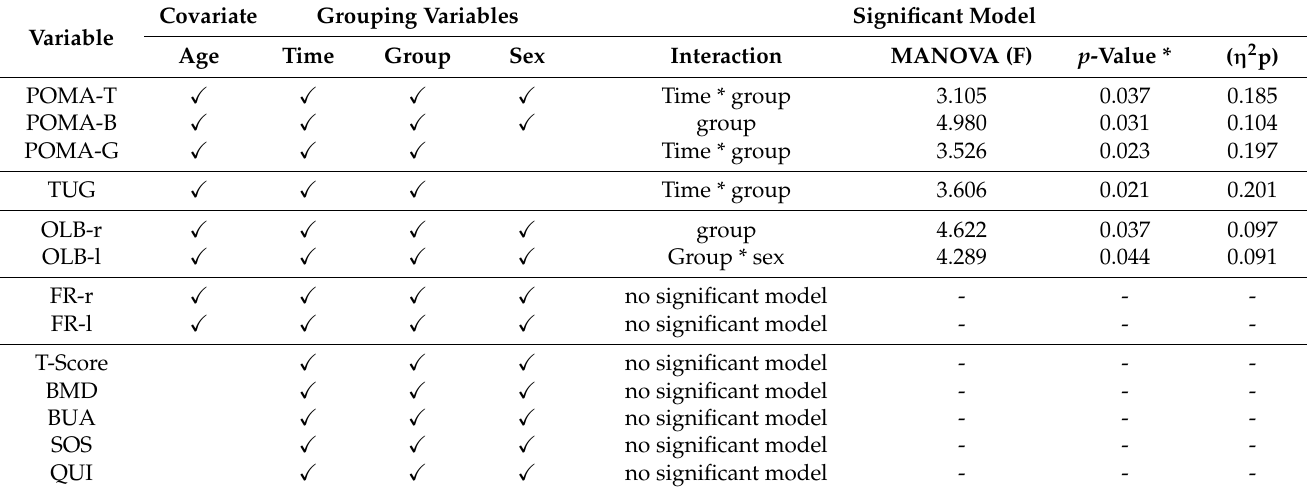
Table 3. Inferential analysis used to calculate the interaction between factors using multivariate analysis of variance (MANOVA). Only statistically significant interaction models with the grouping variables and the significant covariates in the model are shown. Effect size is expressed as the partial eta squared ( η 2 p).